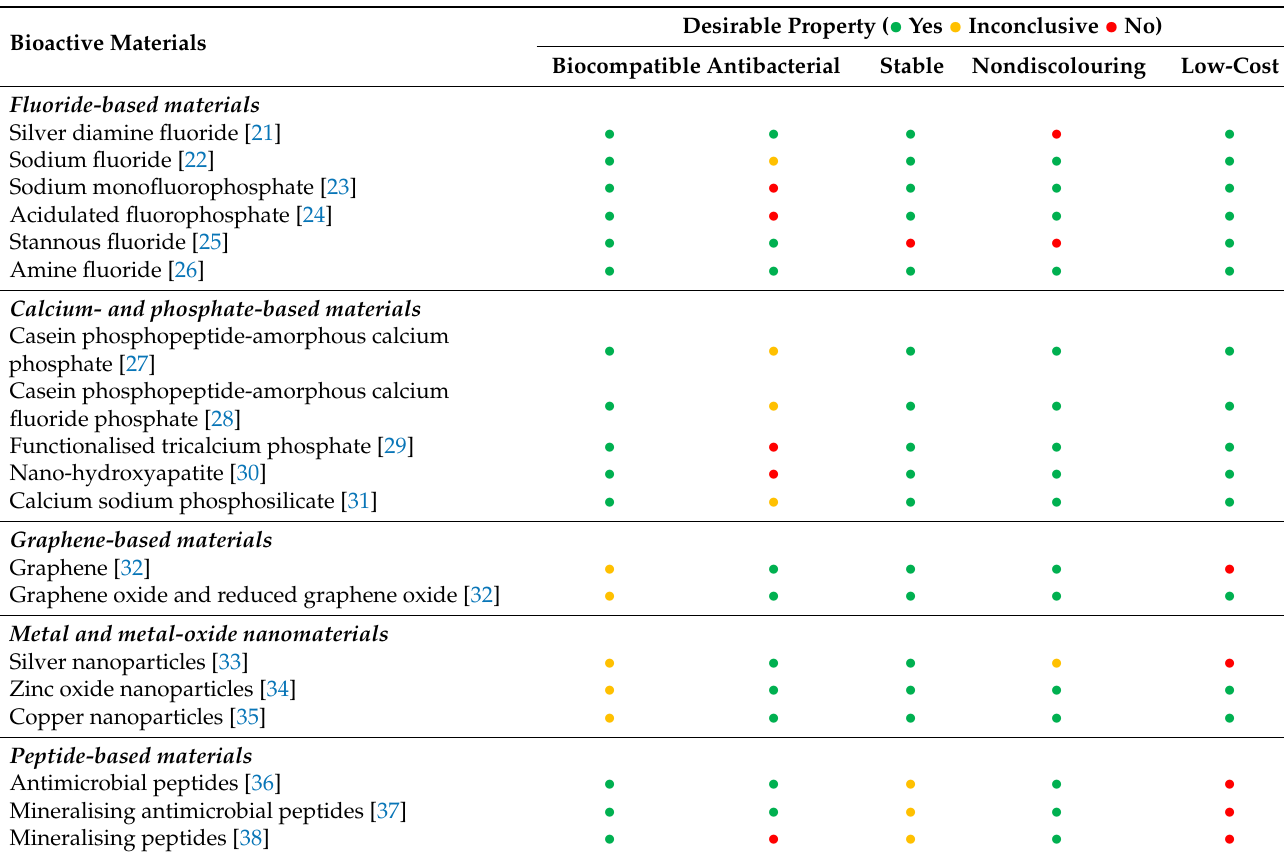
Table 1. Desirable properties of various bioactive